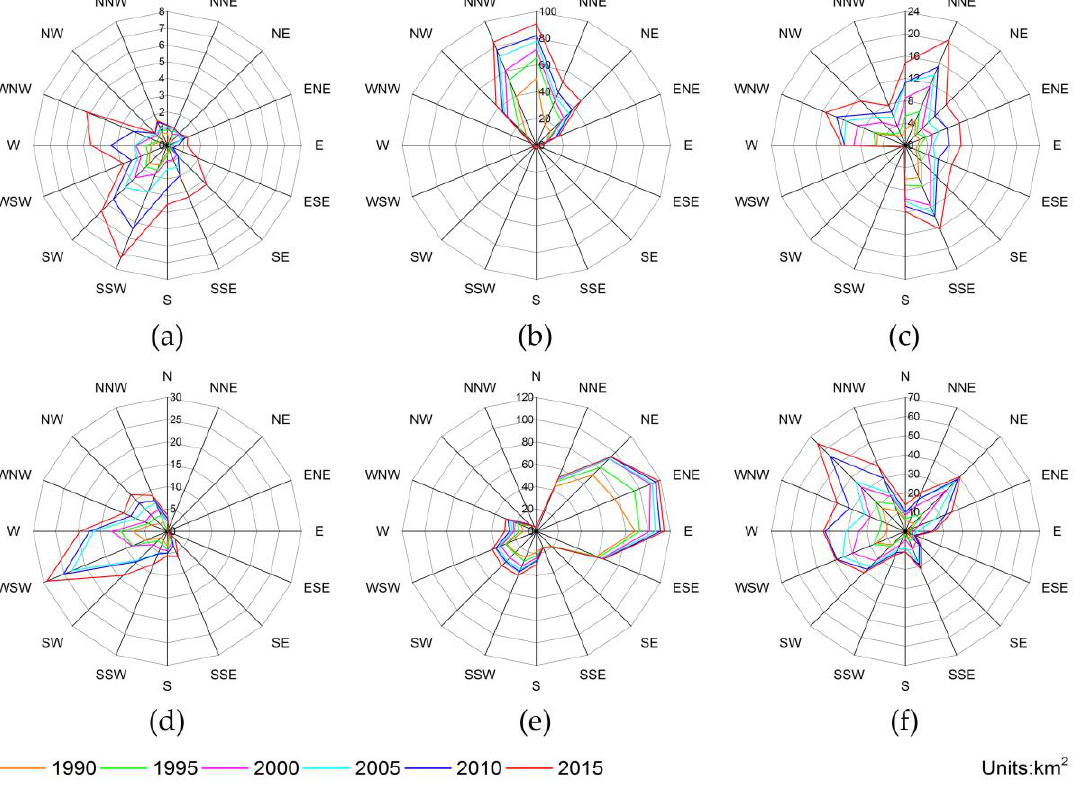
Figure 5. Spatial orientation of urban expansion in typical cities from 1990 to 2015: ( a ) Xishuangbanna; ( b ) Yangon; ( c ) Vientiane; ( d ) Phnom Penh; ( e ) Bangkok; and ( f ) Ho Chi Minh City.